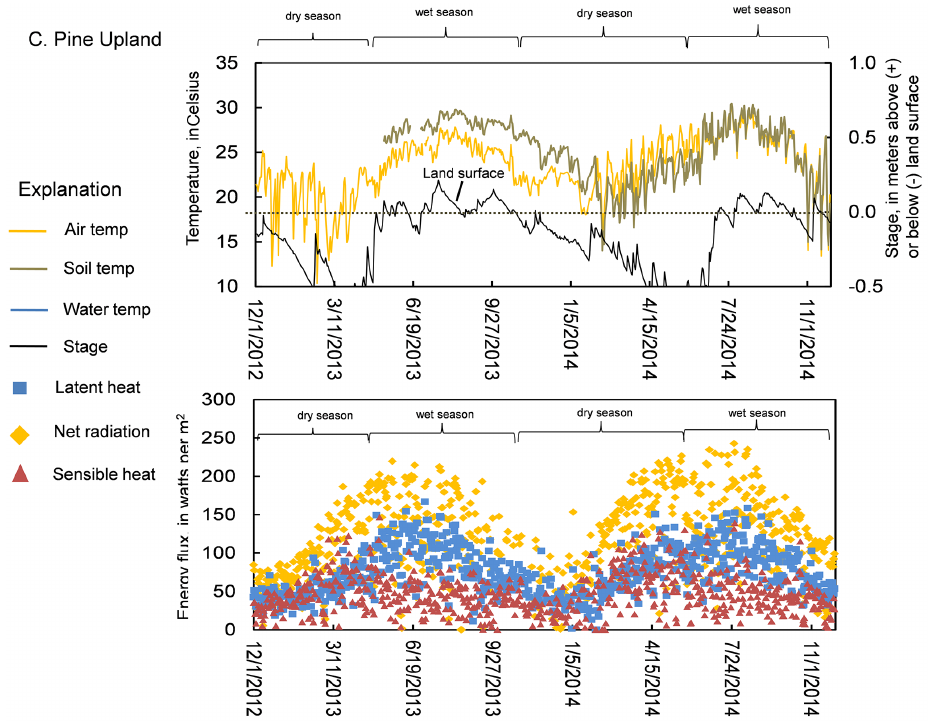
Figure 4. Mean daily temperature and surface energy fluxes. Dates are given in the format